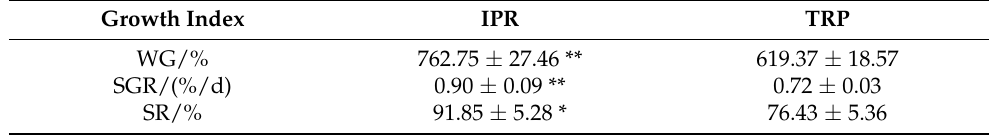
Table 3. Growth index of the yellow catfish cultured in IPR and TRP.